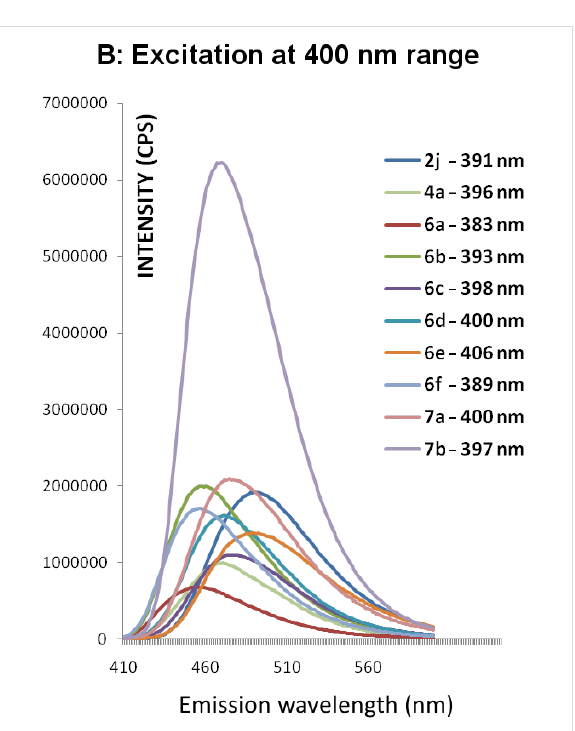
Figure 4: Emission spectra of compounds 2j , 4a , 6a – f and 7a , b after excitation at their absorption λ max in the range of 383–406 nm in aceto- nitrile (1 × 10 − 4